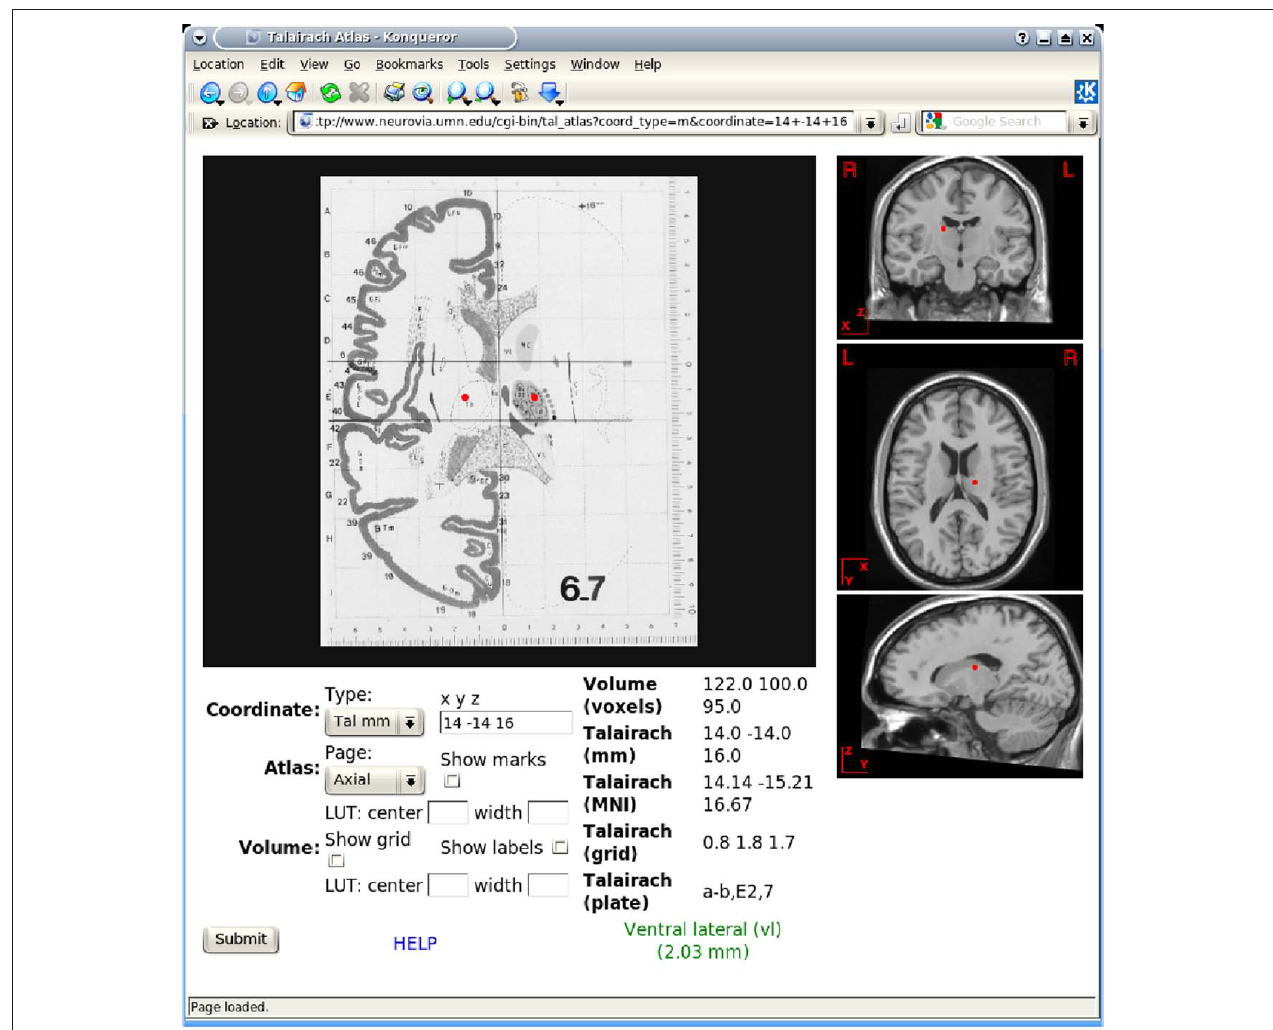
FIGURE 7 | The Web-based INC Interactive Talairach Atlas queried with a coordinate from the Brede